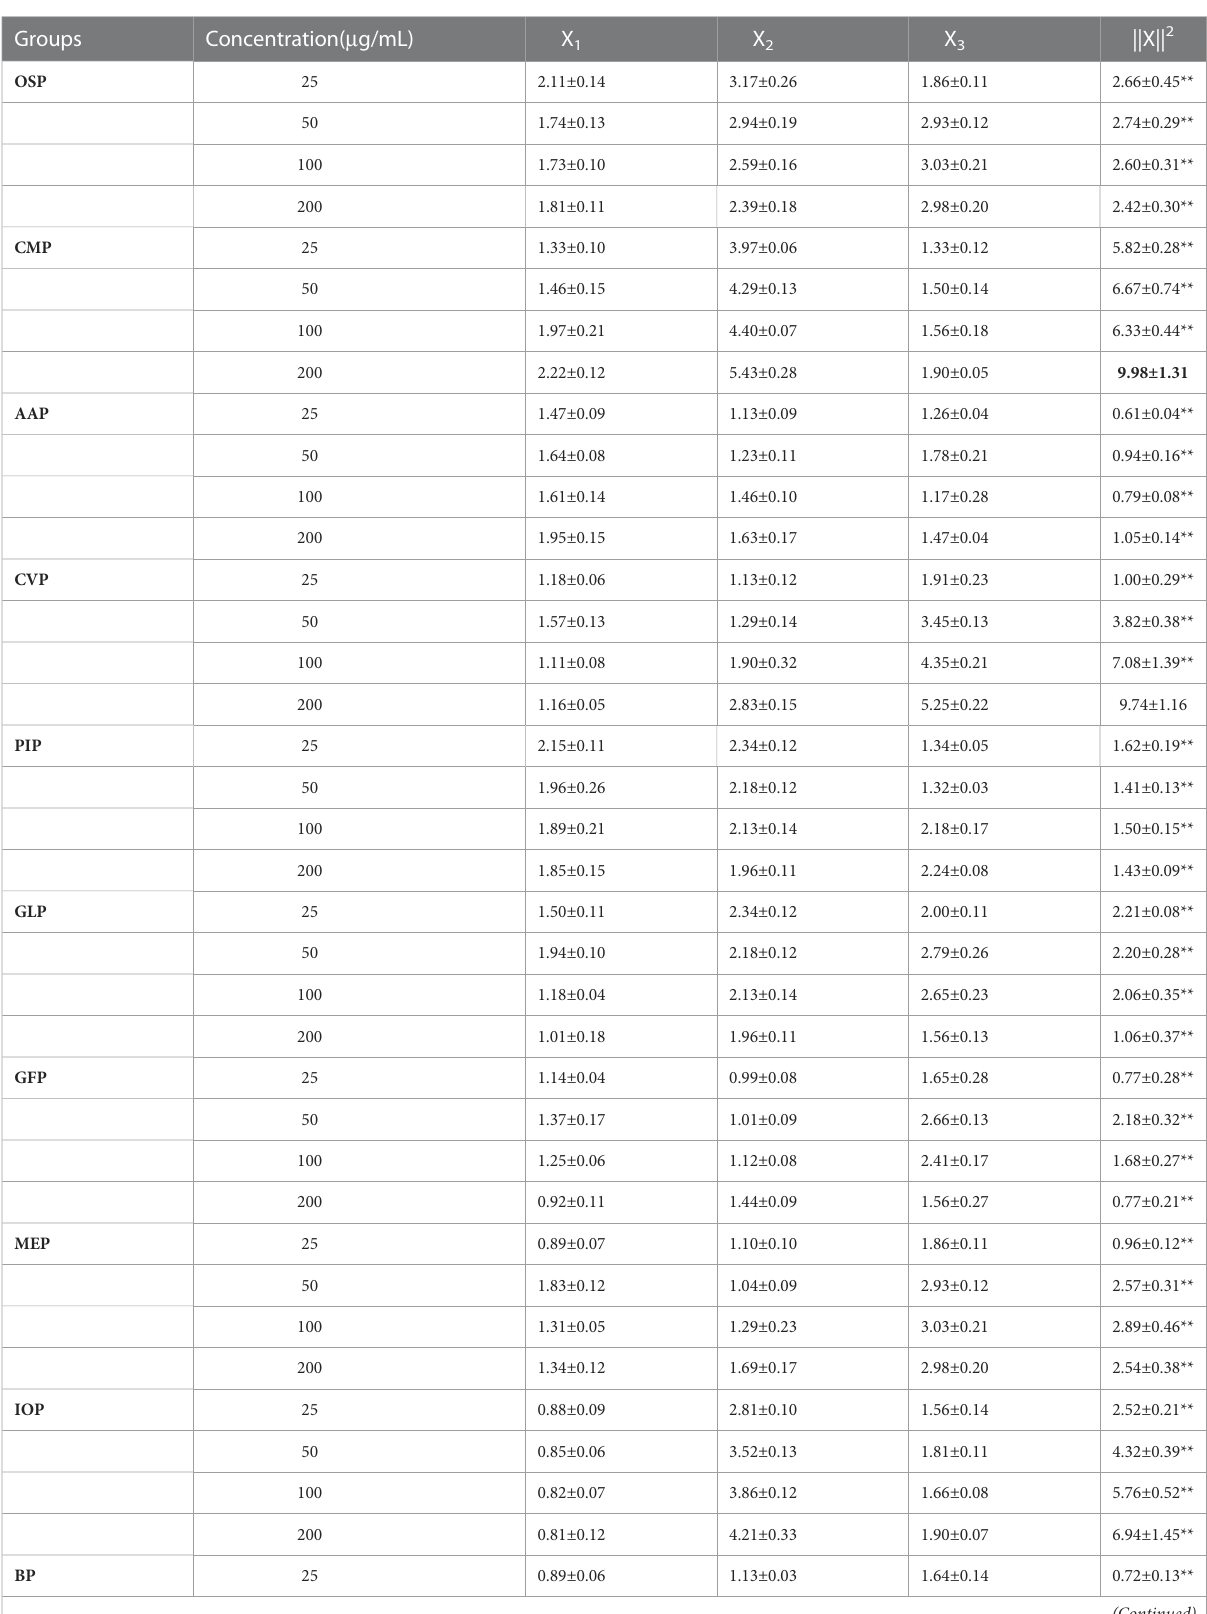
TABLE 3 Comparison of the immune activity of twenty-two edible mushroom proteins (n=5).